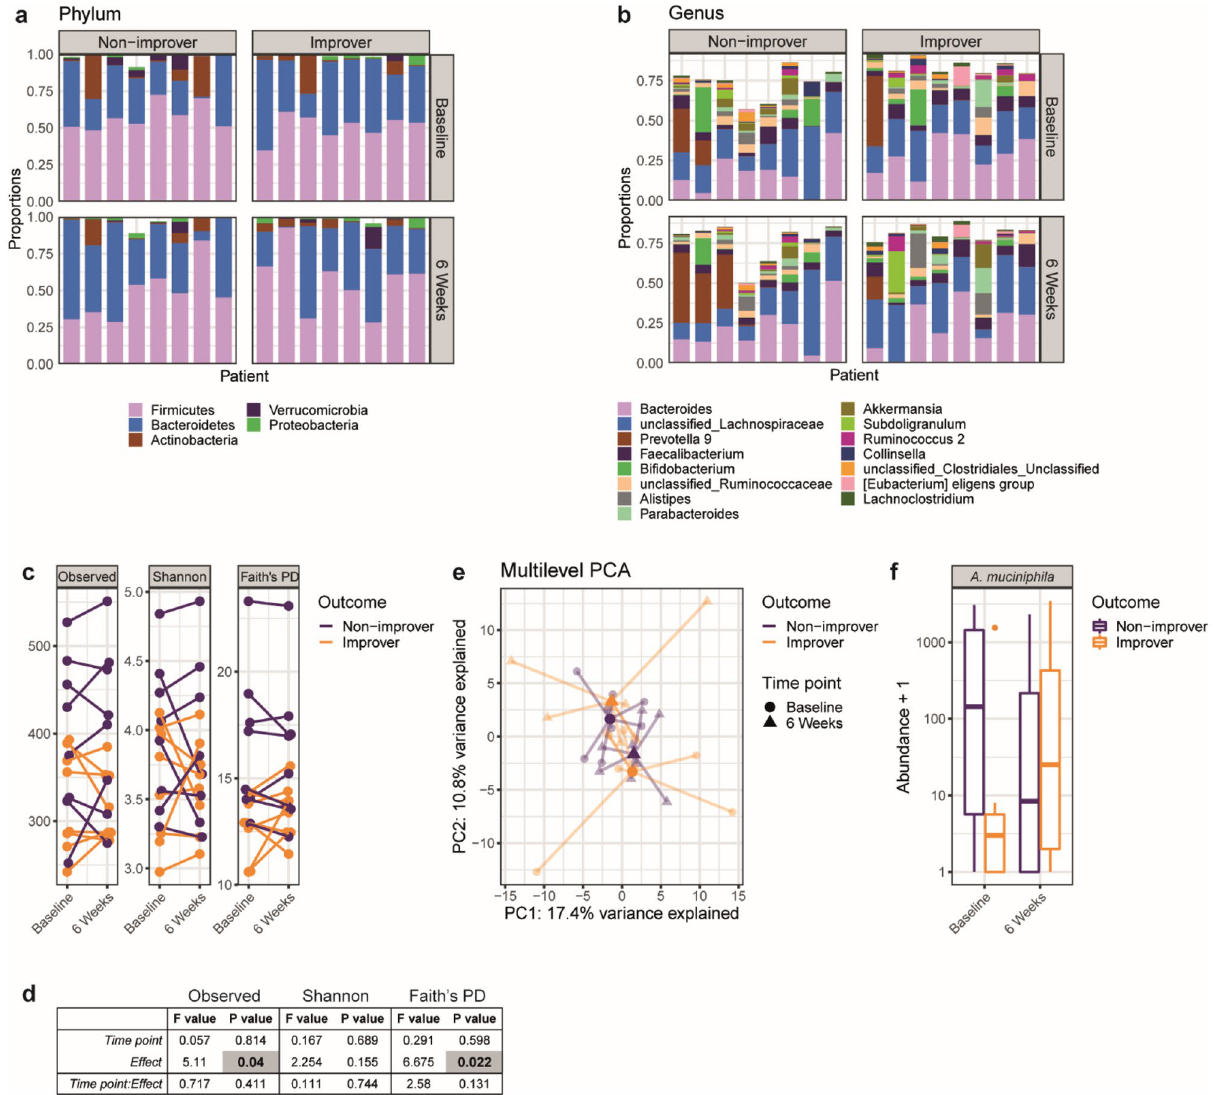
on relative abundance of top 5 phyla ( a ) or top 15 genera ( b ). Patients are grouped based on a normalization of sensitivity status (improvers), or unaltered sensitivity status (non-improvers) over the course of six weeks. Each column represents paired samples of one patient at baseline and 6 weeks. ( c ), ( d ) Microbial richness described according to α-diversity metrics Observed species, Shannon index, and Faith’s Phylogenetic Diversity (PD). Observed species and Faith’s PD are generally lower for improvers. Results of linear mixed effects model presented in ( d ). ( e ) Community analysis by multilevel principle component analysis ( p = 0.002, PERMANOVA). Bold symbols represent centroids of each sample group, while light symbols indicate individual samples. ( f ) Abundance of Akkermansia muciniphila is associated with the change in sensitivity status ( p = 0.007,